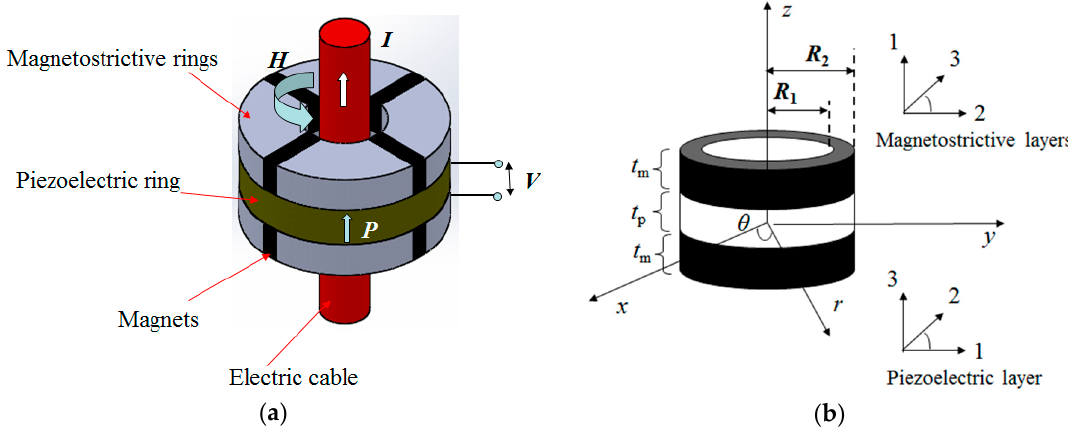
Figure 1. The magnetoelectric (ME) laminated ring: ( a ) An illustration of the configuration. The arrows indicate the directions of AC current ( I ), the polarization ( P ) of the piezoelectric ring, and the magnetic field ( H ); ( b ) The physical model.